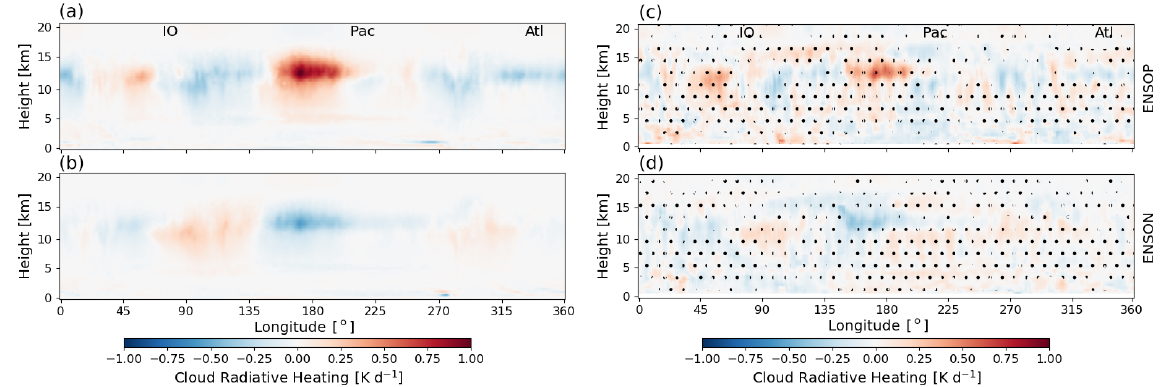
Figure 9. As in Fig. 8 but showing the cloud radiative heating anomalies from EC-Earth3 during positive (a) and negative (b) ENSO compared to the average, and cloud radiative heating anomaly differences between CloudSat/CALIPSO observations and EC-Earth3 (EC- Earth3 minus CloudSat/CALIPSO) during positive (c) and negative (d) ENSO. The differences where a Student t test has a 95% confidence based on monthly mean values are marked with a black dot (c–d) .